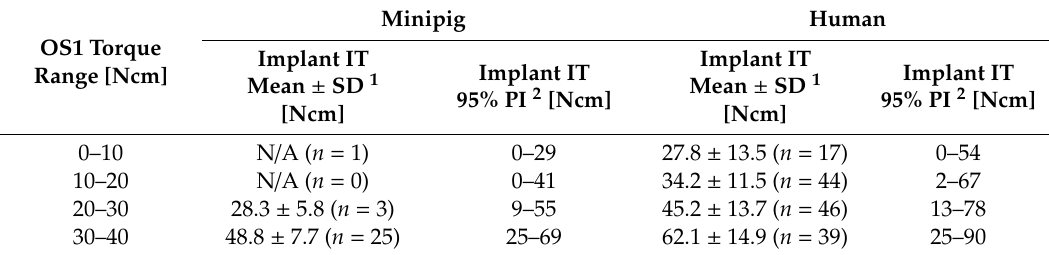
Table 3. Mean ± standard deviation (SD) and 95% prediction intervals (PI) of implant insertion torque for di ff erent OS1 torque ranges in minipigs and human subjects (Figure